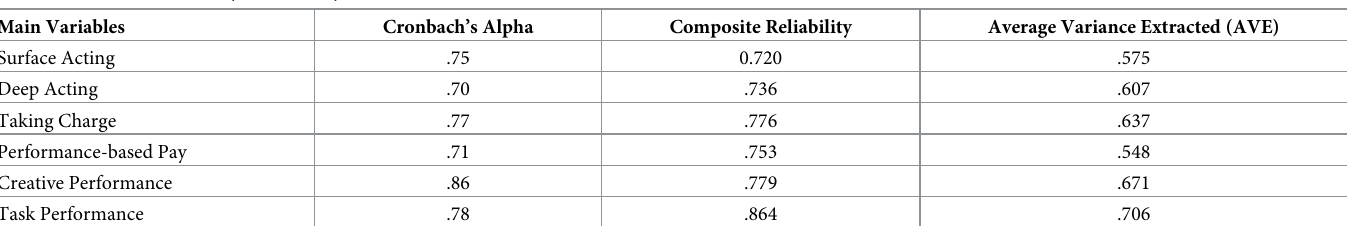
Table 2. Construct reliability and validity.